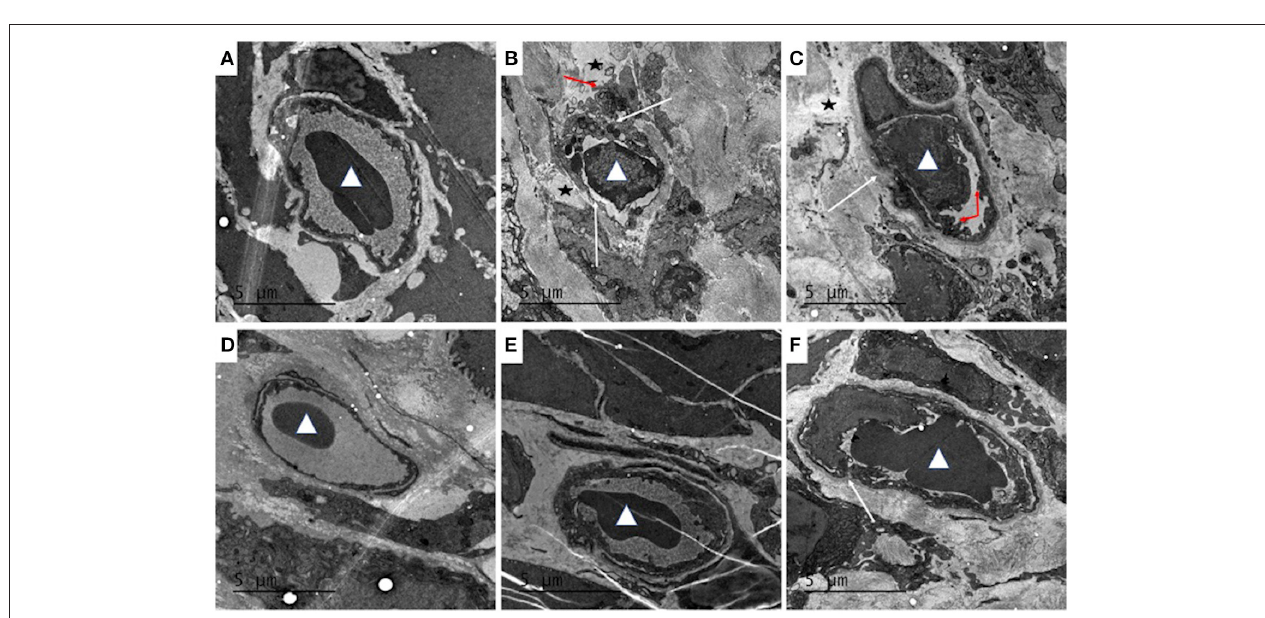
FIGURE 6 | Effects of QCS on DSS-induced ultrastructural pathology changes in colon tissue. Histopathological examination of colon tissues by TEM (4,200 × ), n = 5. (A) Control; (B) DSS model; (C) QCS 0.36 g/kg; (D) QCS 0.72 g/kg; (E) QCS 1.44 g/kg; (F) SASP 0.135 g/kg. Red blood cells (white triangles). Platelet aggregation (red arrow). The microvascular basement membrane and endothelium (white